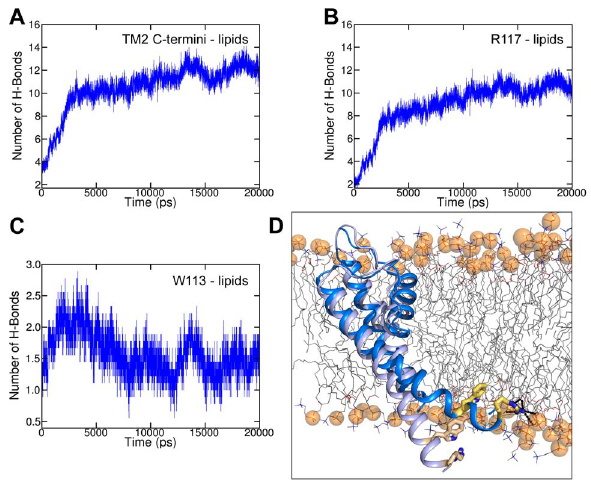
Figure 6. Lipid interactions of TM2 helices during activation gate opening. A) Average number of H-bonds between H-bond forming residues (W113 and R117) of the C-terminal TM2 helices and lipid head groups was measured over time. B) Average number of H- bonds of R117 with lipids. C) Average number of H-bonds of W113 with lipids. D) Representation of one SU in the closed (light blue) and open (marine blue) conformation with lipids. H-bond forming residues W113 and R117 are shown as yellow sticks. Lipids are depicted as gray lines while phosphate groups are shown as orange spheres. Dashed black lines represent